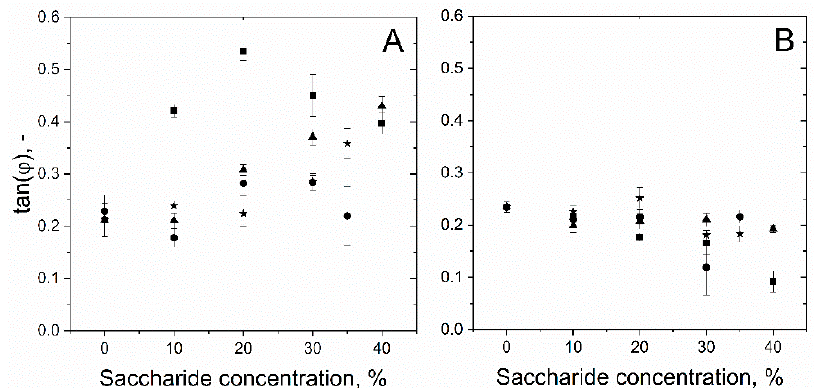
Figure 4. Influence of different saccharide concentrations on the calculated tan ( ϕ ) of polysorbate 80 ( A ) and β -lactoglobulin ( B ) samples at the air–water interface, with sorbitol ( (cid:78) ), sucrose ( (cid:70) ), maltose ( • ), and maltodextrin ( (cid:4)